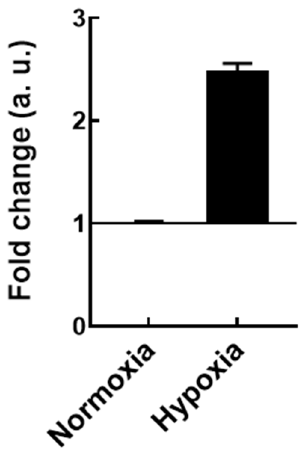
Figure 4. HIF-1 α mRNA expression level obtained in normoxia or hypoxia conditions in HepG2 cells. Results were normalized to cells in normoxia and are presented as median ± SD ( n = 4).